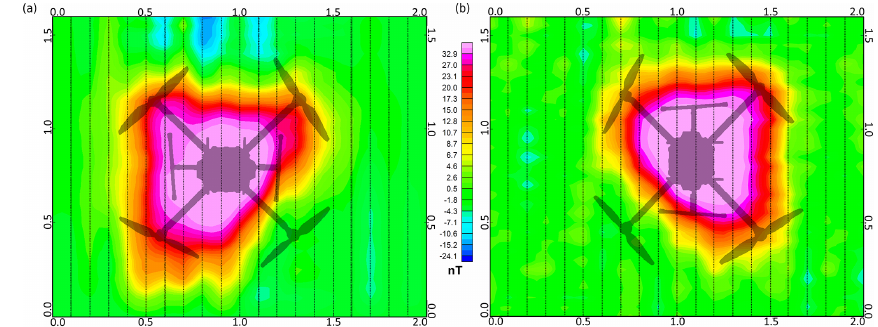
Figure 6. Interference map of the QRH facing magnetic north (a) and east (b) . Border units are in metres.